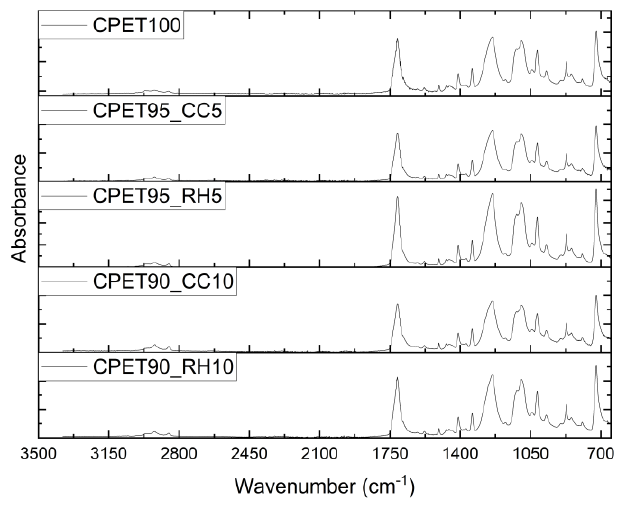
Figure 10. ATR-FTIR spectra for CPET/biofiller blends.